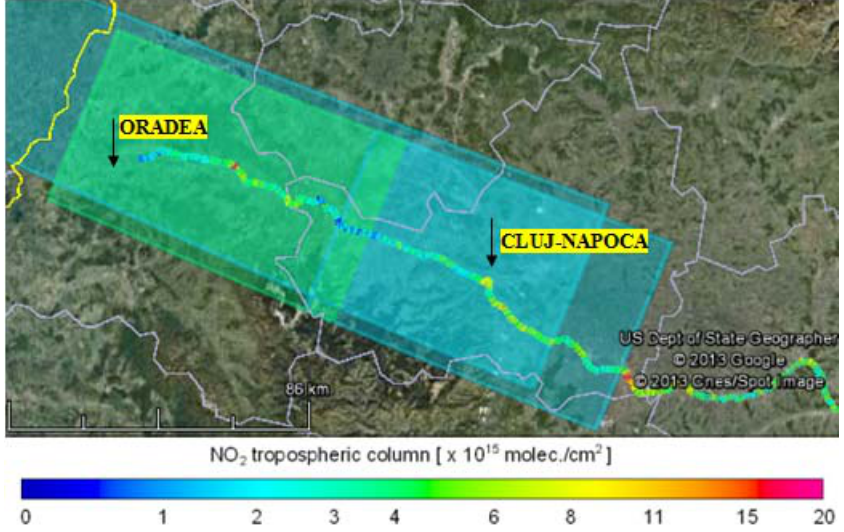
Figure 8. Color coded tropospheric NO measurements on 18 July 2011 (line) and GOME-2 tropospheric NO day